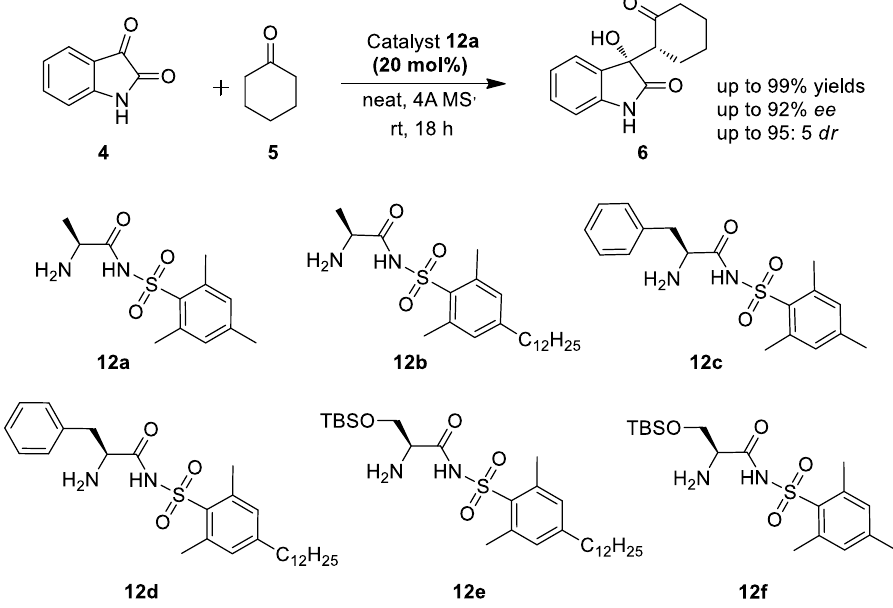
Scheme 10. Asymmetric aldol reaction catalyzed by amino acid sulphonamides.